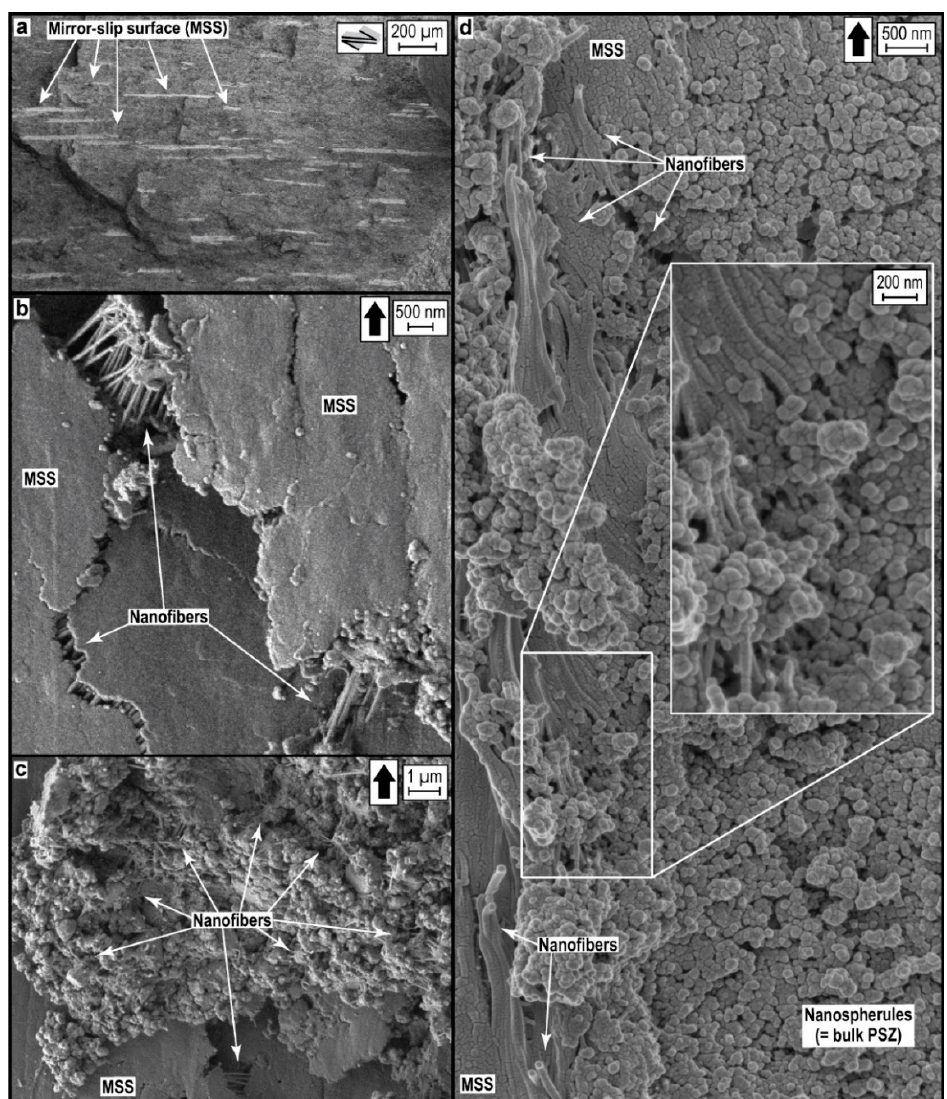
Figure 6. Principal slip zone with mirror-slip surfaces formed in simulated calcite gouge sheared in LVF tests ( v = 10 − 6 to 10 − 5 ms − 1 , see [140]). Secondary electron micrographs. ( a ) Taken at an angle of 52° to the shear plane. The patches that are elongated parallel to the shear direction represent MSSs. ( b ) Stretched nanofibers and ( c ) nanofibers within the bulk PSZ. ( d ) Alignment of nanospherules at the edge of an MSS. (a) to (d) are top views onto the shear plane. The micrographs shown in ( a , d ) are from sample SEMB of [140], taken using a FEI Nova Nanolab FIB-SEM. The micrographs in ( b , c ) are of samples sheared using a gas-medium deformation apparatus installed at the Geological Survey of Japan (Tsukuba, Japan), and taken using a JEOL-7400F FEG-SEM. Returning to patchy MSSs formed in LVF experiments using calcite gouge ( v = 10 − 6 m/s, σ n eff = 50